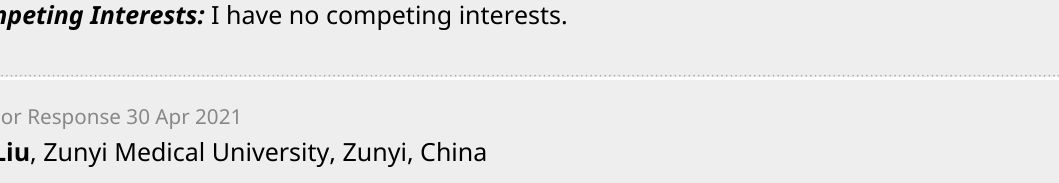
Figure legend of Figure 1: should be total RNA from mouse liver was extracted and processed for RT-PCR